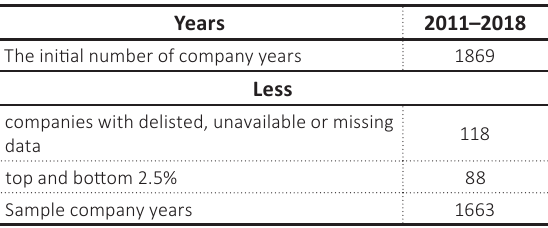
Table 1. The selected